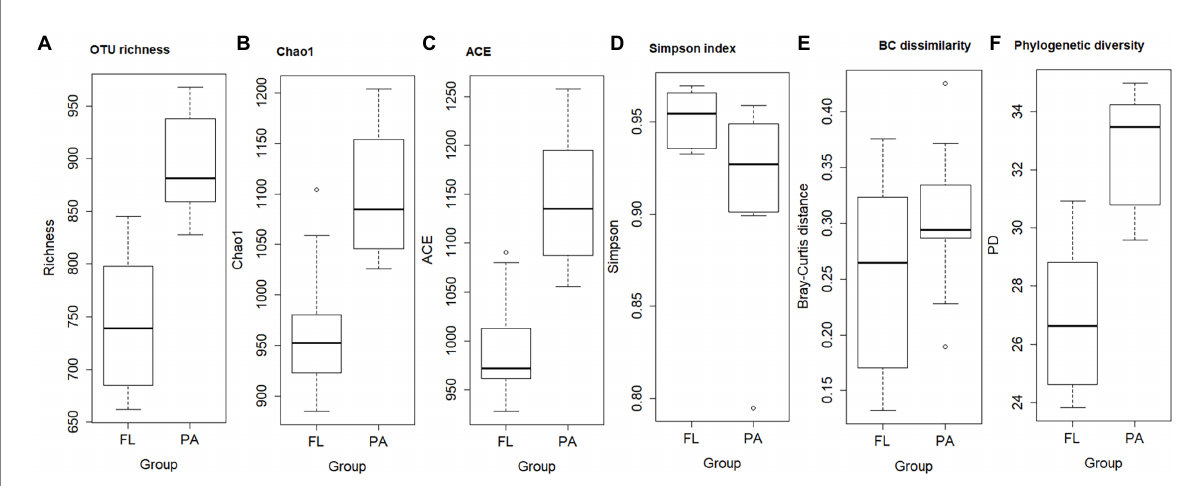
FIGURE 4 Boxplot of α -diversity indexes ( A . OTU richness; B . Chao1; C . ACE; D. Simpson), β -diversity (Bray–Curtis dissimilarity) (E) , and phylogenetic diversity (PD) (F) of FL and PA bacterial community.